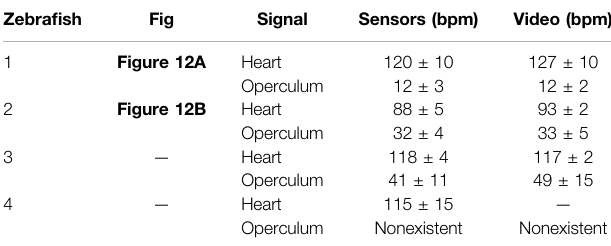
Analyzing Table 2 , it is observed that the zebra fi sh heart rate